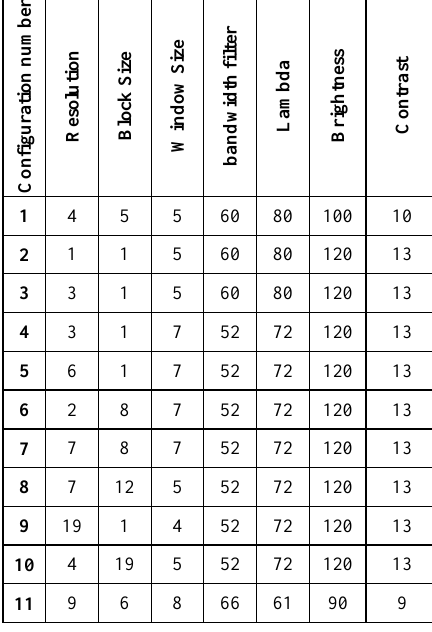
Table 2. Parameters for individual configurations of disparity map